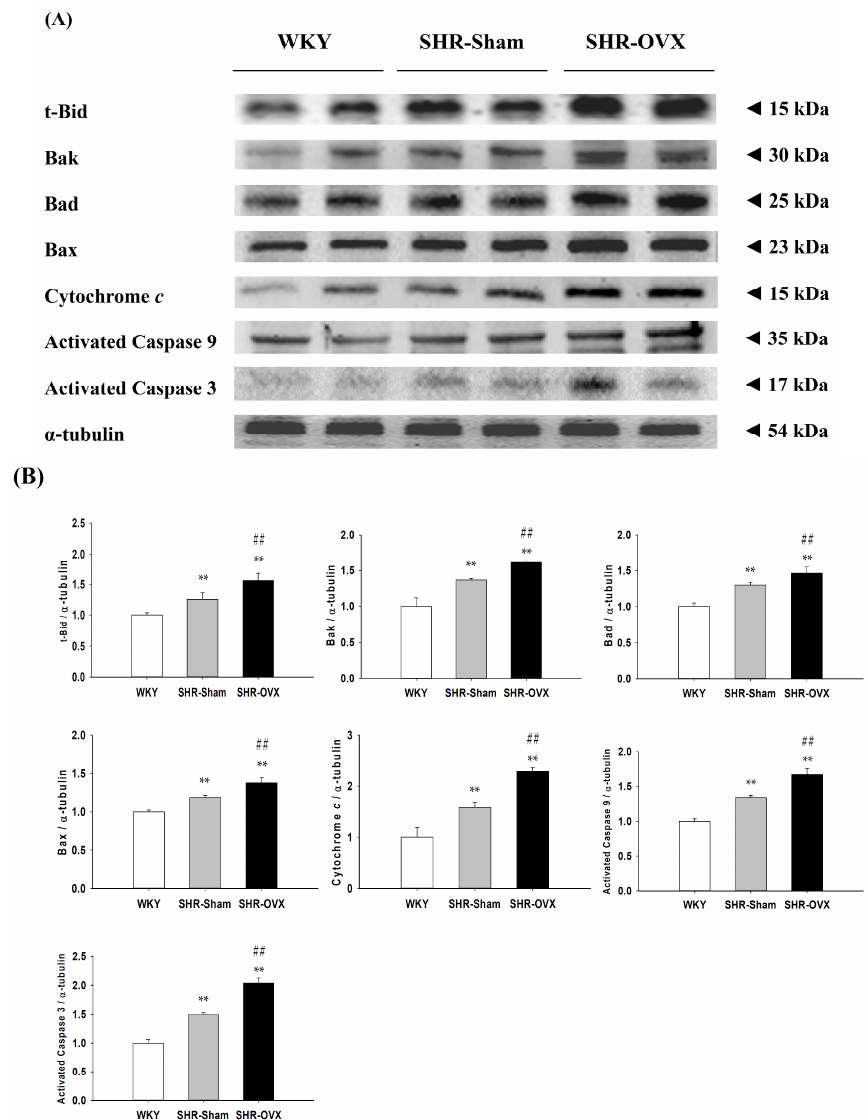
Figure 4. ( A ) The two representative protein products of t-Bid, Bak, Bad, Bax, cytochrome c , activated caspases 9 and activated caspases 3 extracted from the left ventricles of the excised hearts from the Wistar Kyoto rats (WKY), SHR with sham-operated (SHR-Sham) and SHR with bilateral ovariectomized (SHR-OVX) were measured by Western blot analysis; ( B ) The bars represent the relative protein quantification of t-Bid, Bak, Bad, Bax, cytochrome c , activated caspases 9 and activated caspases 3 on the basis of α -tubulin and the average protein expression levels in the WKY group normalized to one, and then, a relative protein expression was calculated for each condition. Data presented as the mean values ± SD ( n = 8 in each group); ** p < 0.01 denotes significant differences from the WKY group; ## p < 0.01 denotes significant differences between the SHR-Sham group and the SHR-OVX group.